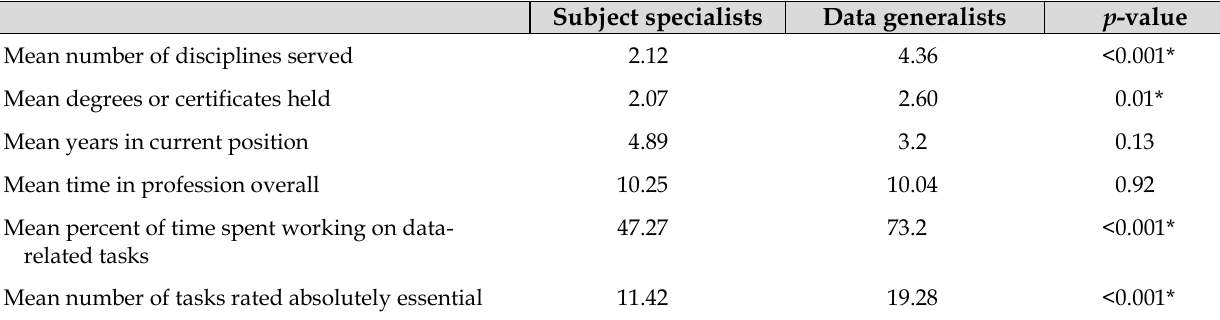
Table 1 Differences between respondents in subject specialists and data generalists